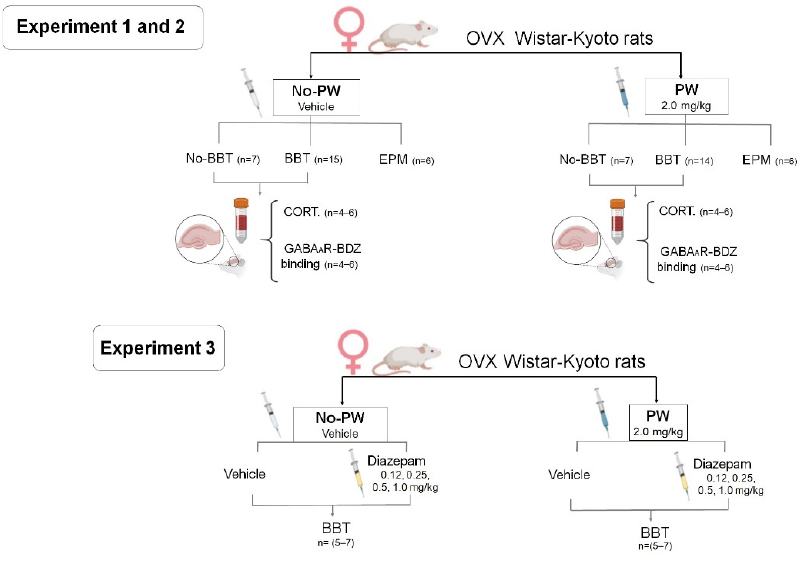
Figure 6. Flowchart of experimental